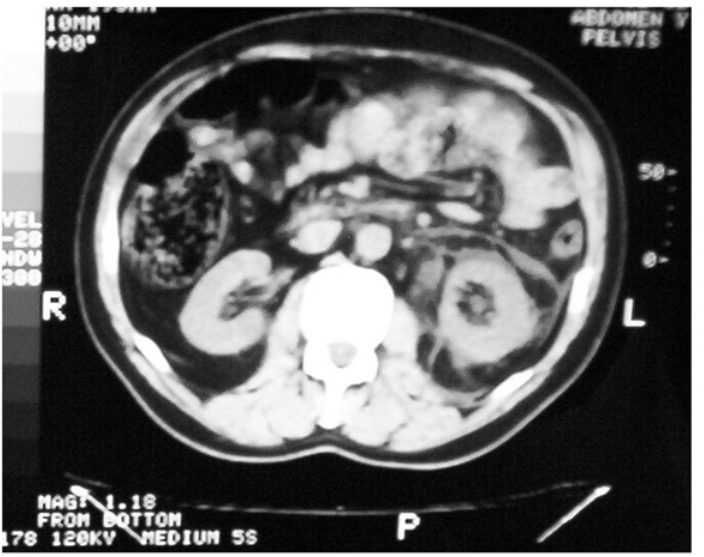
FIGURE 3 . Unenhanced CT (4/17/06). Perinephric stranding, small perinephric collection and ureteral